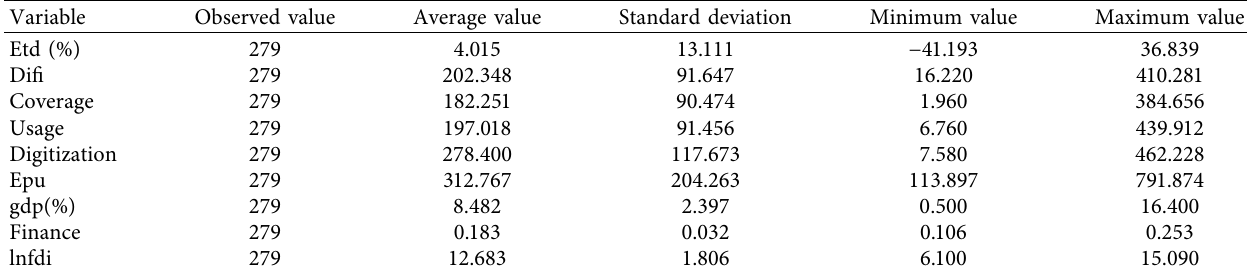
Table 2: Descriptive statistics of the variables.